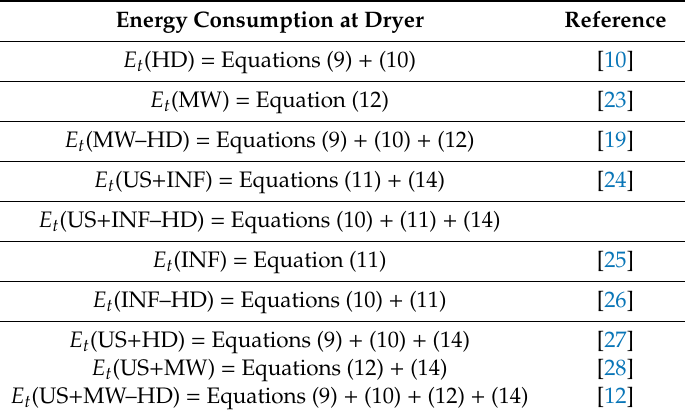
Table 3. Specific energy consumption (SEC) equations for di ff erent dryers and US pretreatment. Energy Consumption at